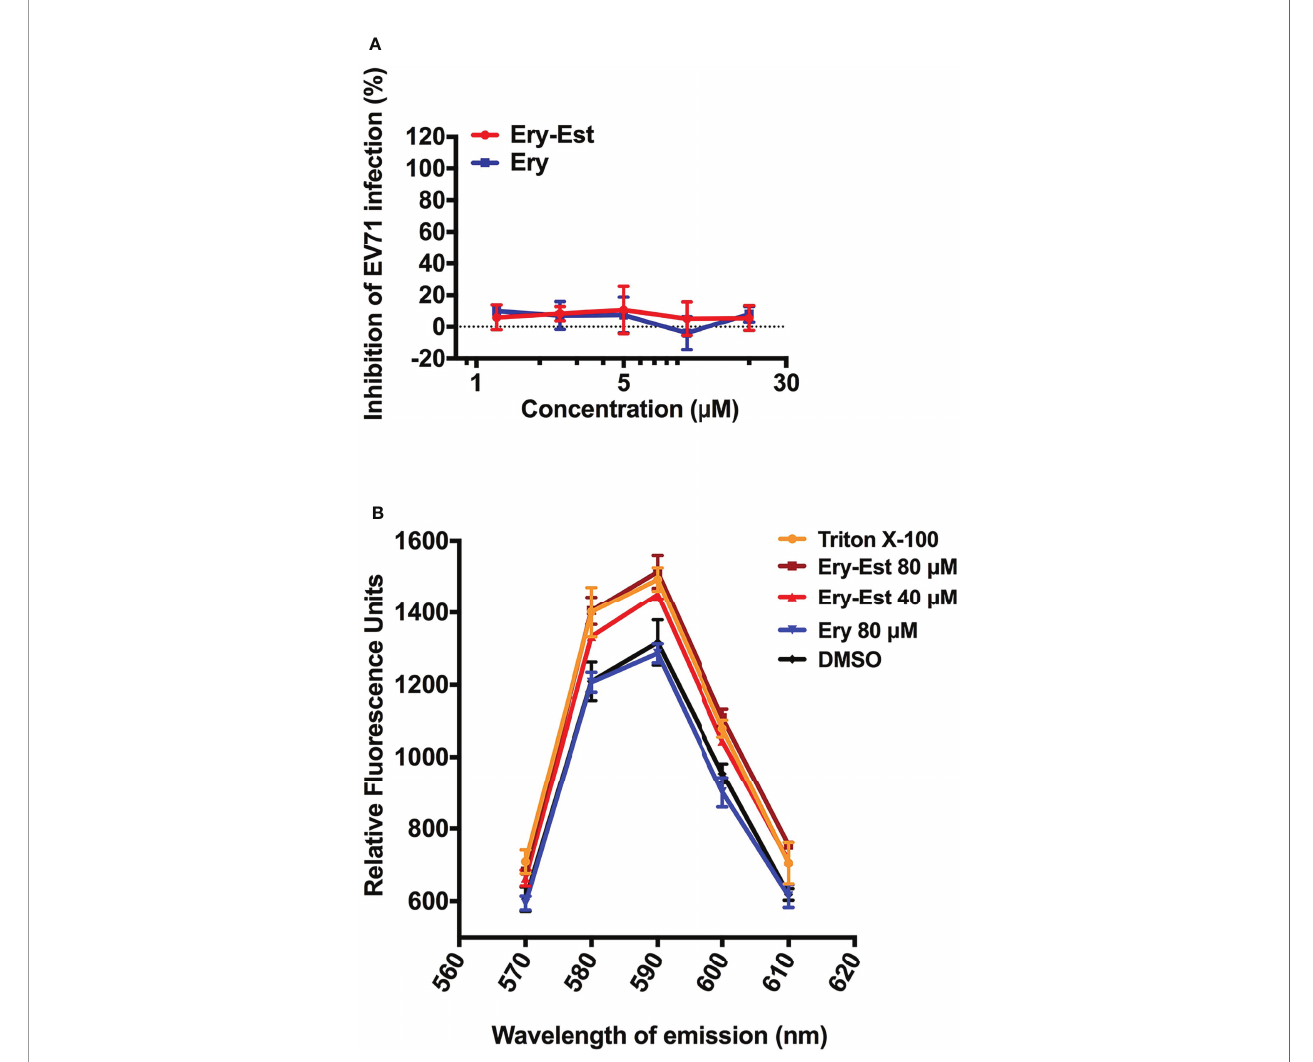
FIGURE 5 | Ery-Est showed no inhibitory activity on non-enveloped virus EV-71 (A) and could disrupted the integrity of liposome encapsulating fl uorescent dye SRB, leading to the increase of the fl uorescence intensity (B) . Each experiment was performed in triplicate, and the data were presented as means ±